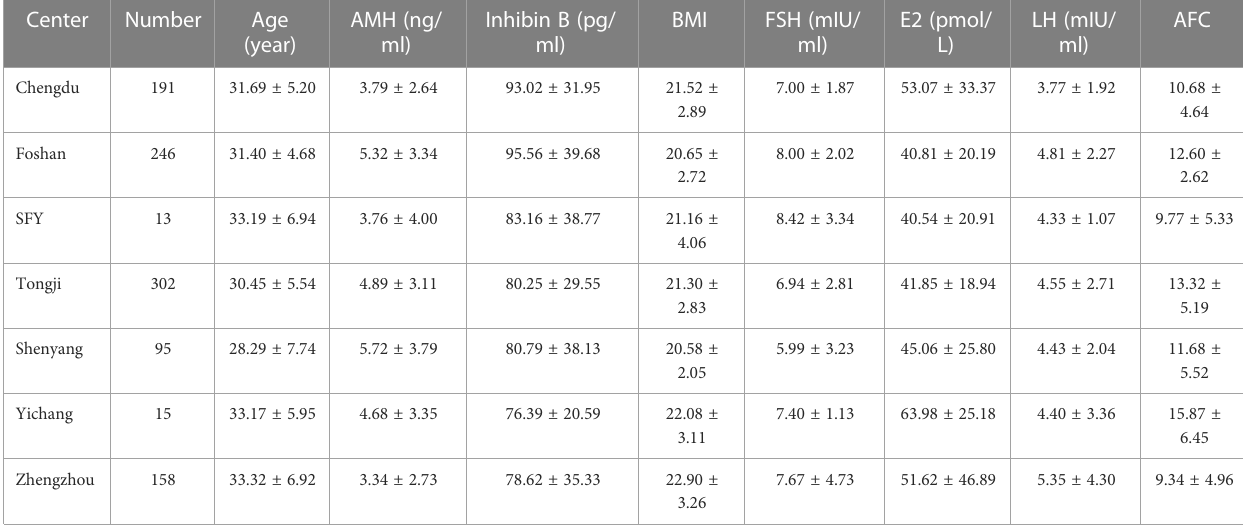
TABLE 1 Description of the features and centers from which the data were obtained. Center